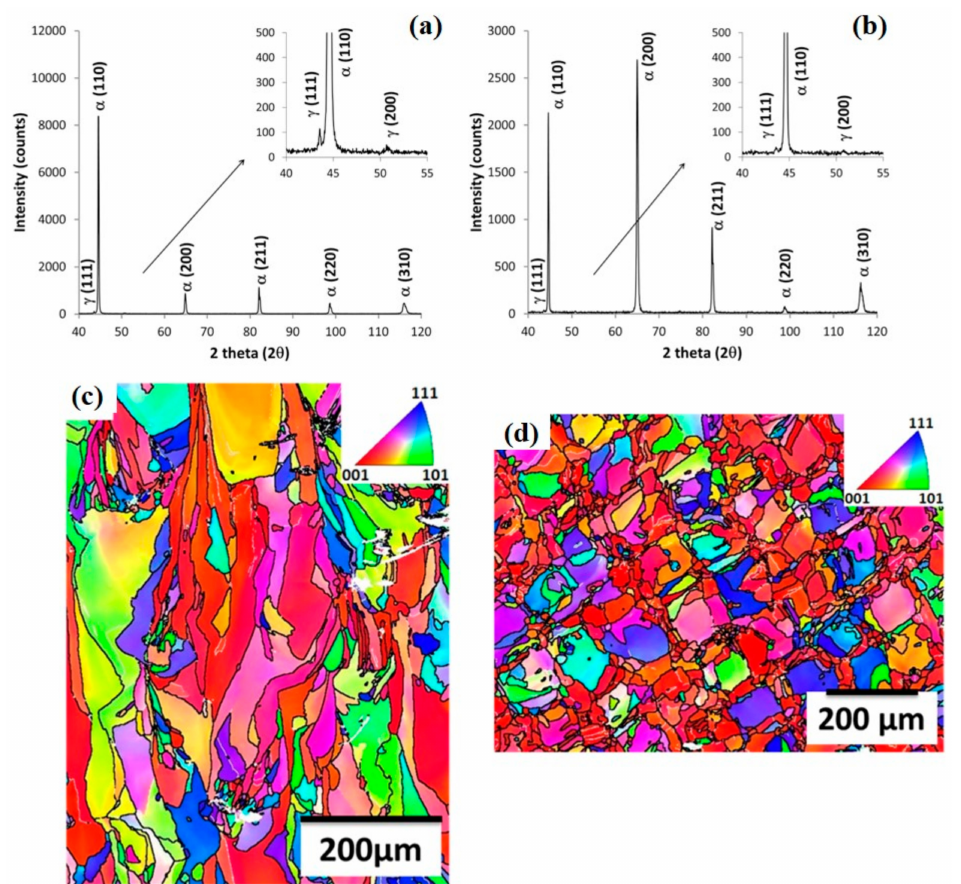
Figure 2. ( a ) XRD spectra and ( c ) EBSD orientation map (Inverse pole figure, IPF Z) of as-built 17–4 PH steel in the ( Y – Z ) plane parallel to the build direction; ( b ) XRD spectra and ( d ) EBSD orientation map (IPF Z) of as-built 17–4 PH steel in the ( X – Y ) plane perpendicular to the build direction